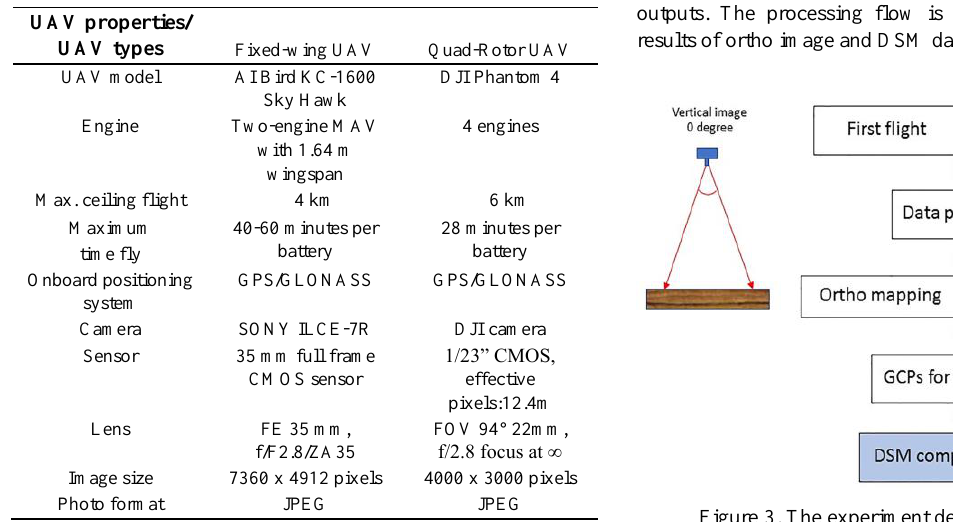
Table 1. The different of UAV platforms, onboard capabilities and technology